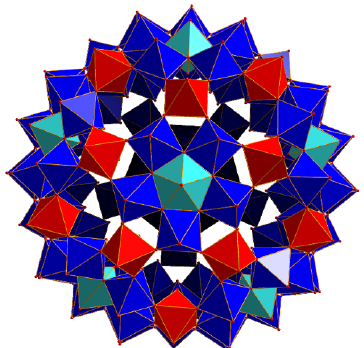
Figure 1. Structure of the spherical {Mo 72 Fe 30 } Keplerate cluster. Mo, Blue and light blue polyhedral; Fe, red polyhedral; Oxygen, red spheres. Fe, red polyhedral; Oxygen, red